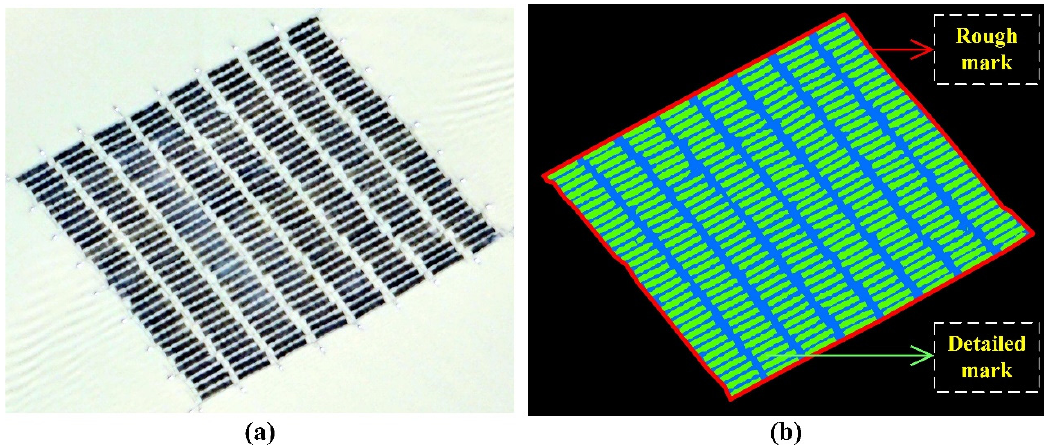
Figure 2. Example of inaccurate supervision of classification. ( a ) Remote sensing image; ( b ) Inaccurate supervised classified image.